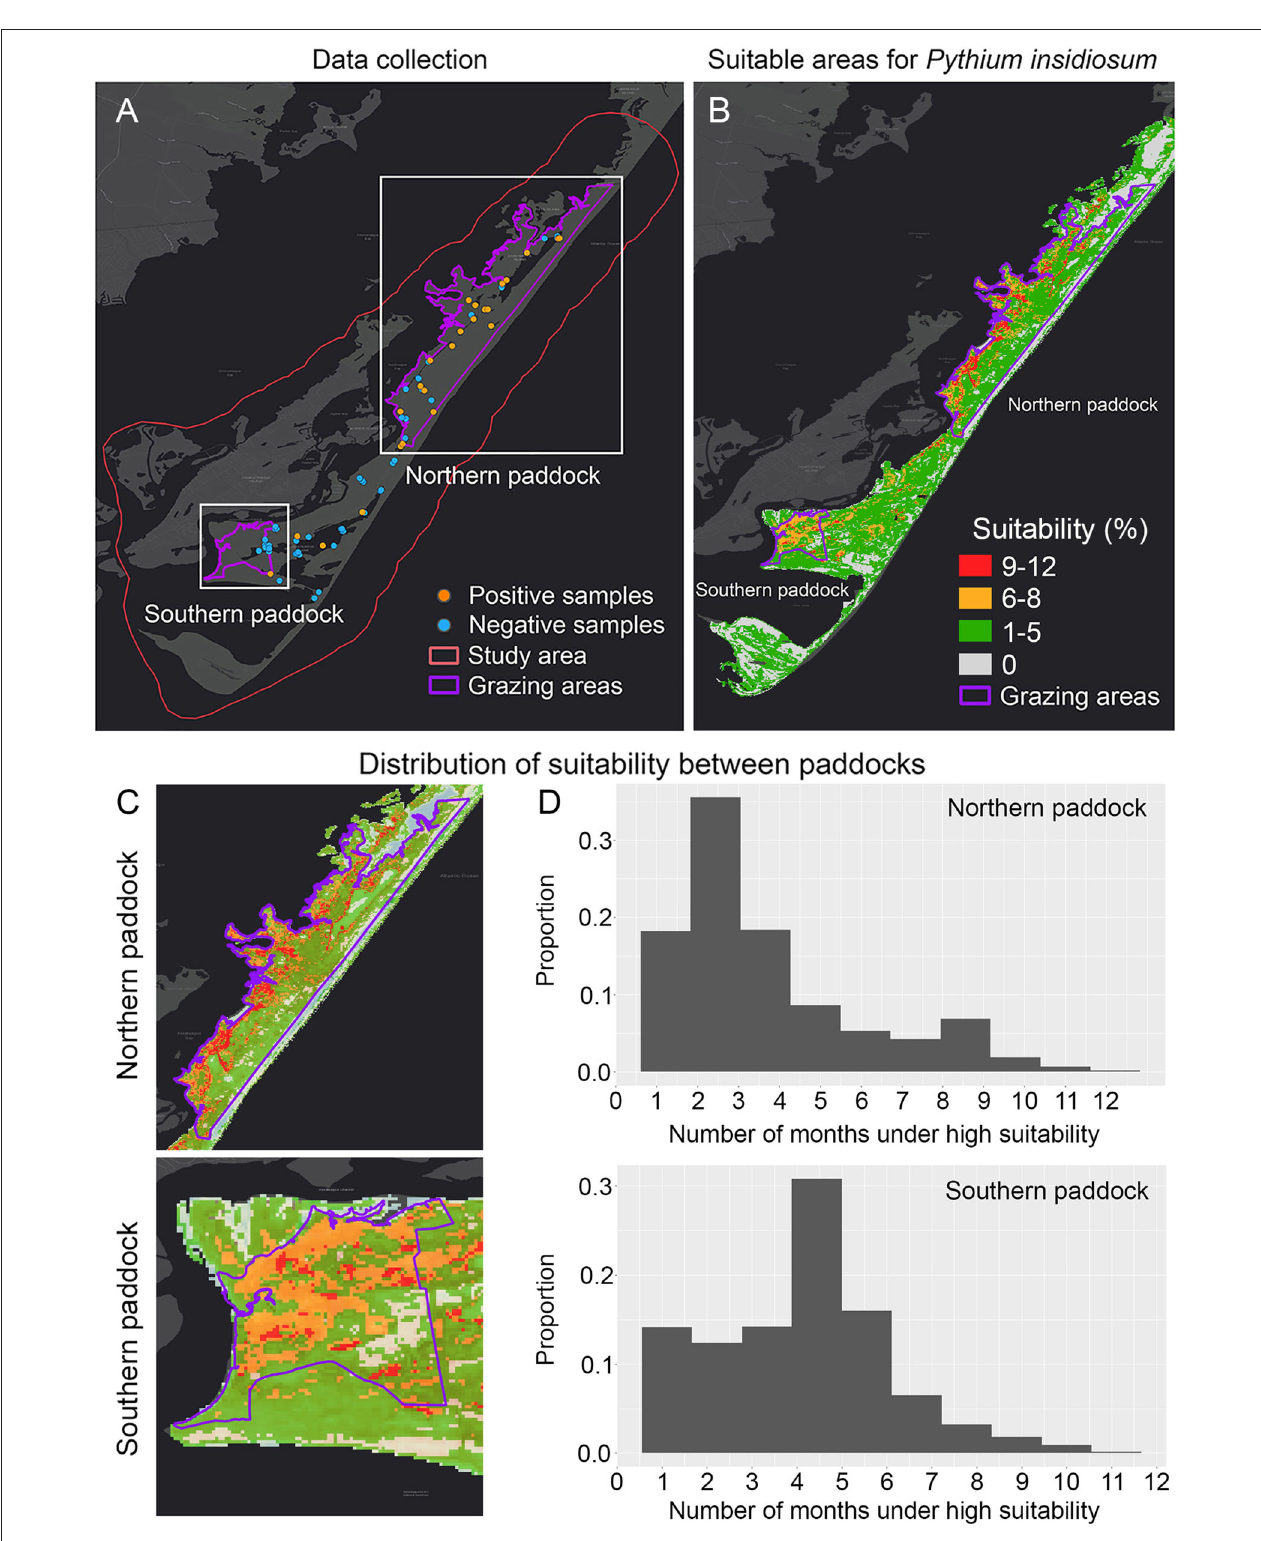
FIGURE 2 | Dynamic ecological niche model showing the most suitable areas of Pythium insidiosum in Chincoteague National Wildlife Refuge. (A) Shows positive and negative P. insidiosum detections in both grazing paddocks, delimited by purple lines. (B) Shows the dynamic ENM results and the expanded visualization of each grazing paddock (C) . (D) Shows the comparison of the predicted suitability weighted distribution for P. insidiosum for each paddock, where suitability values range from 0 to 1, with 1 being the most suitable.